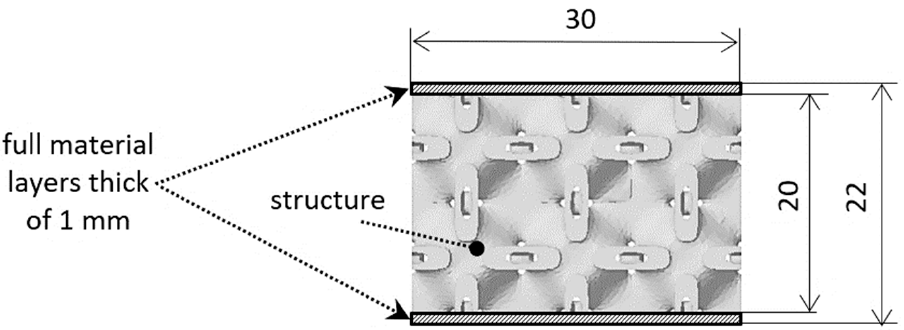
Figure 2. The cross-sectional layout of the sample design.